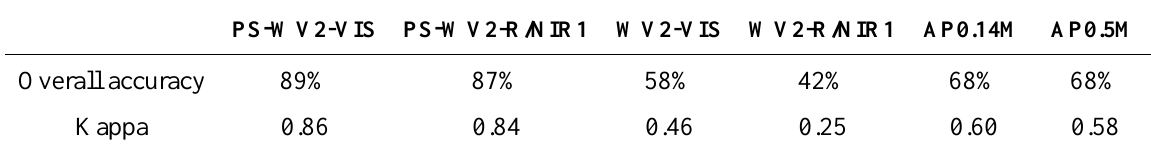
Table 3. Overall accuracy and Kappa statistics obtained for each classification.